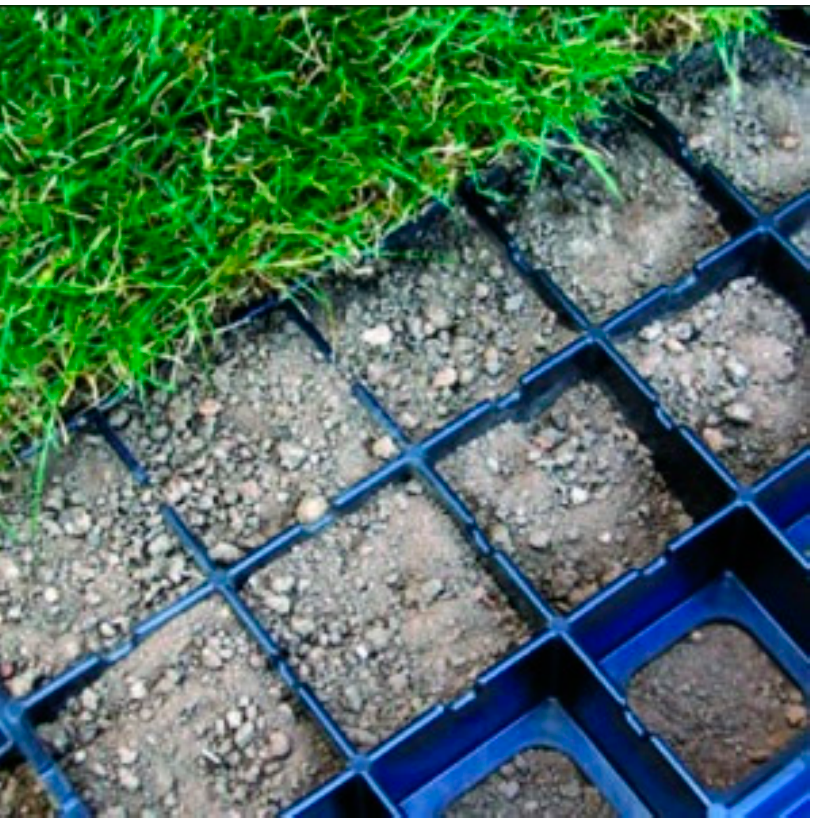
Figure 1. GEOBLOCK ® Grass Pavers.